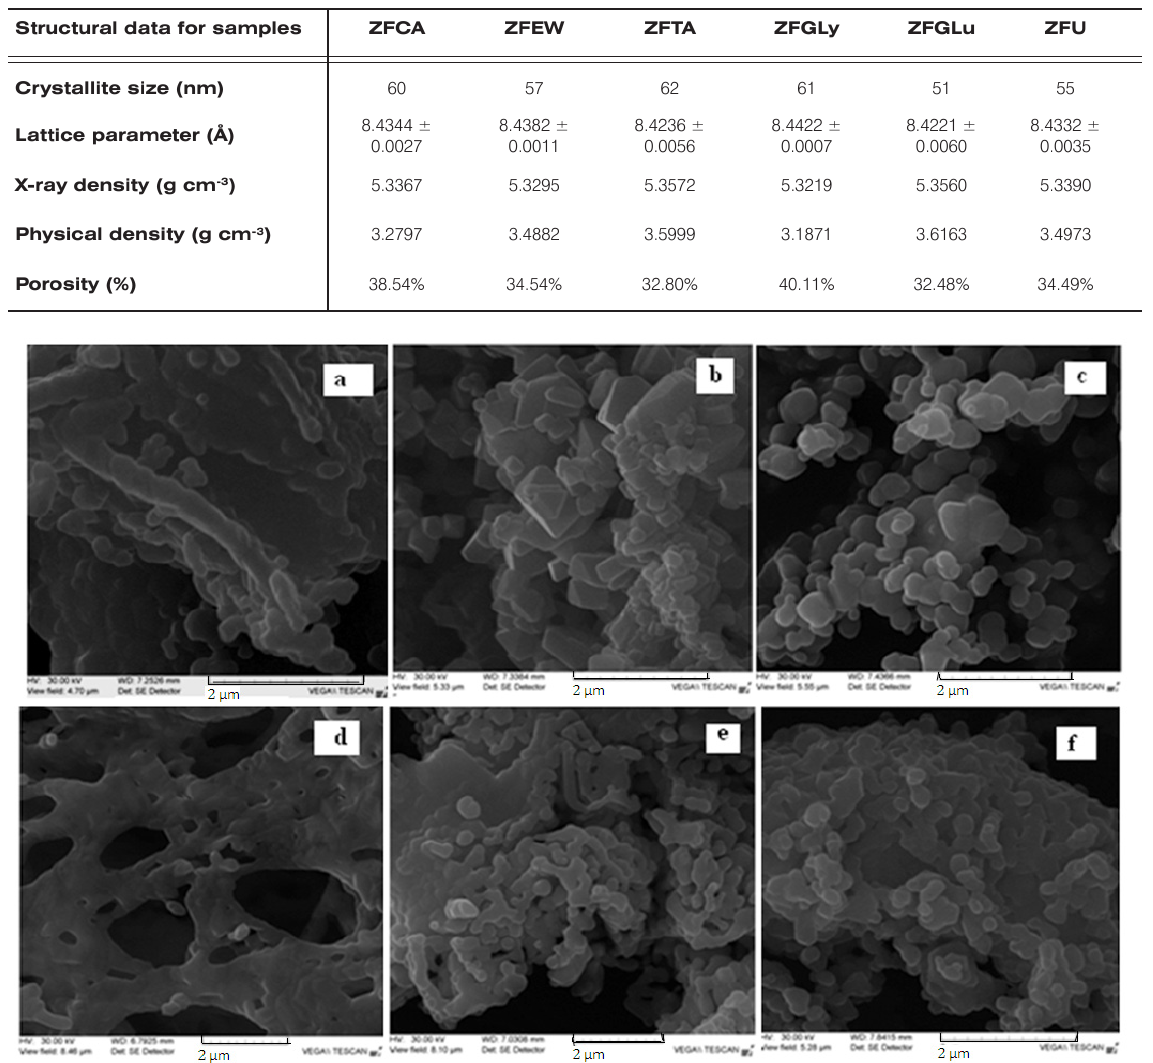
Figure 3. SEM micrographs for ZF samples after heat treatment at 1173 K: (a) ZFCA, (b) ZFEW (a) (c) ZFTA (d) ZFGLy (e) ZFGLu (f)